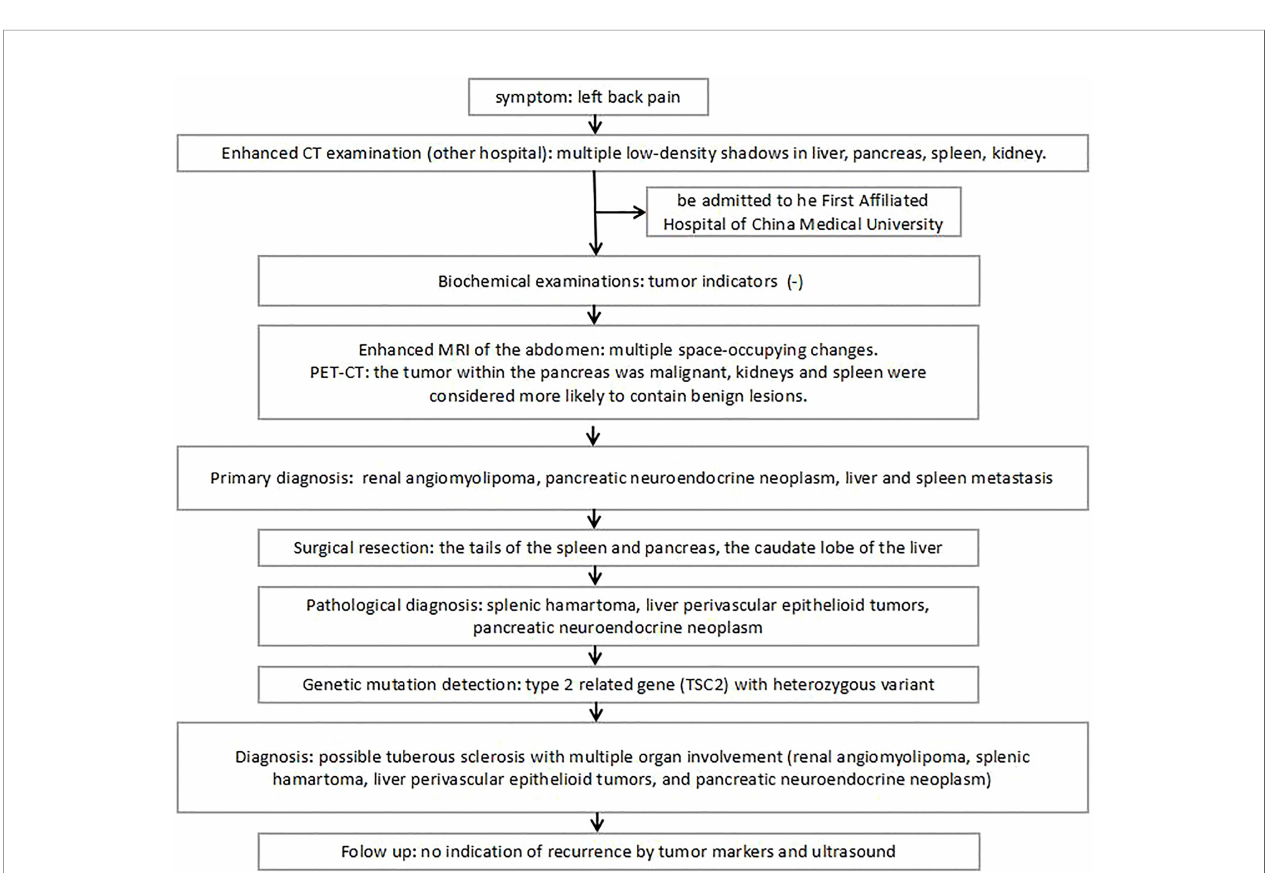
FIGURE 7 | Diagnosis and treatment algorithm based on this case